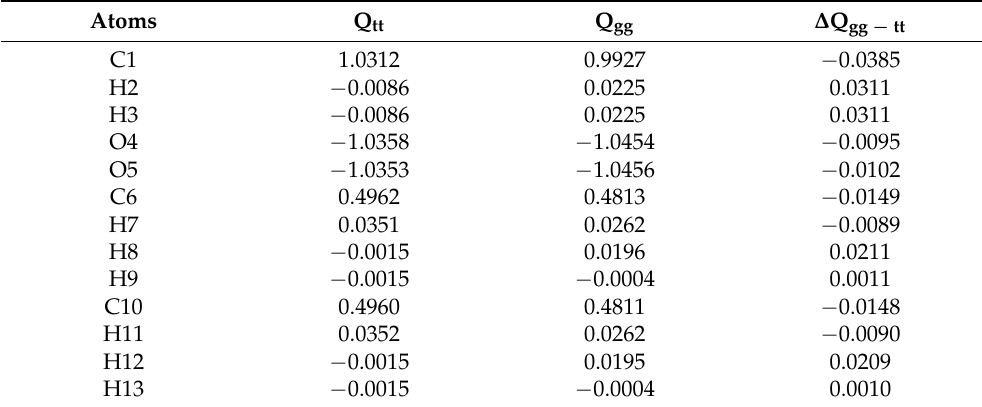
Table 3. QTAIM charges (in electron, e) of all atoms in DMM for its gg and tt conformers, and their